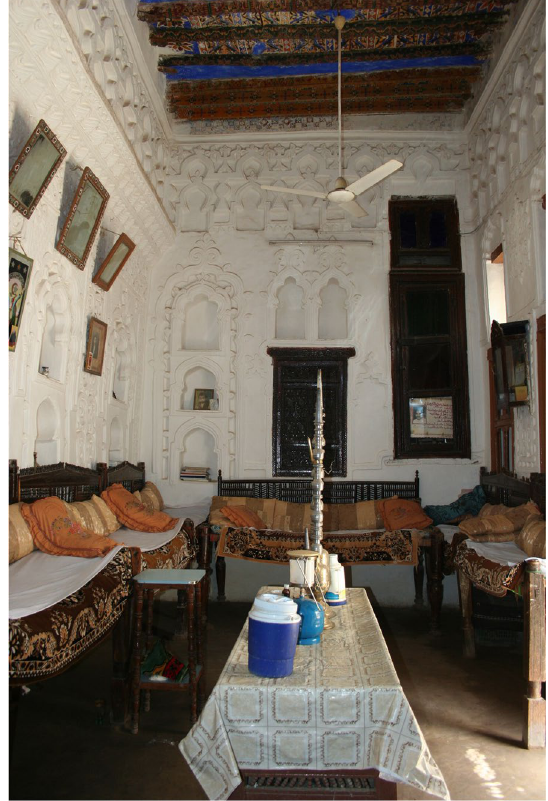
Fig. 4 Zabid, interior of a historic merchant house (Source: the author)